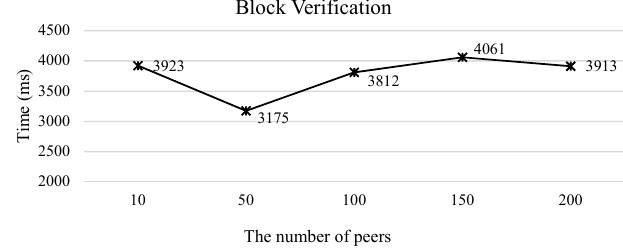
Figure 4. Block Verification Time.